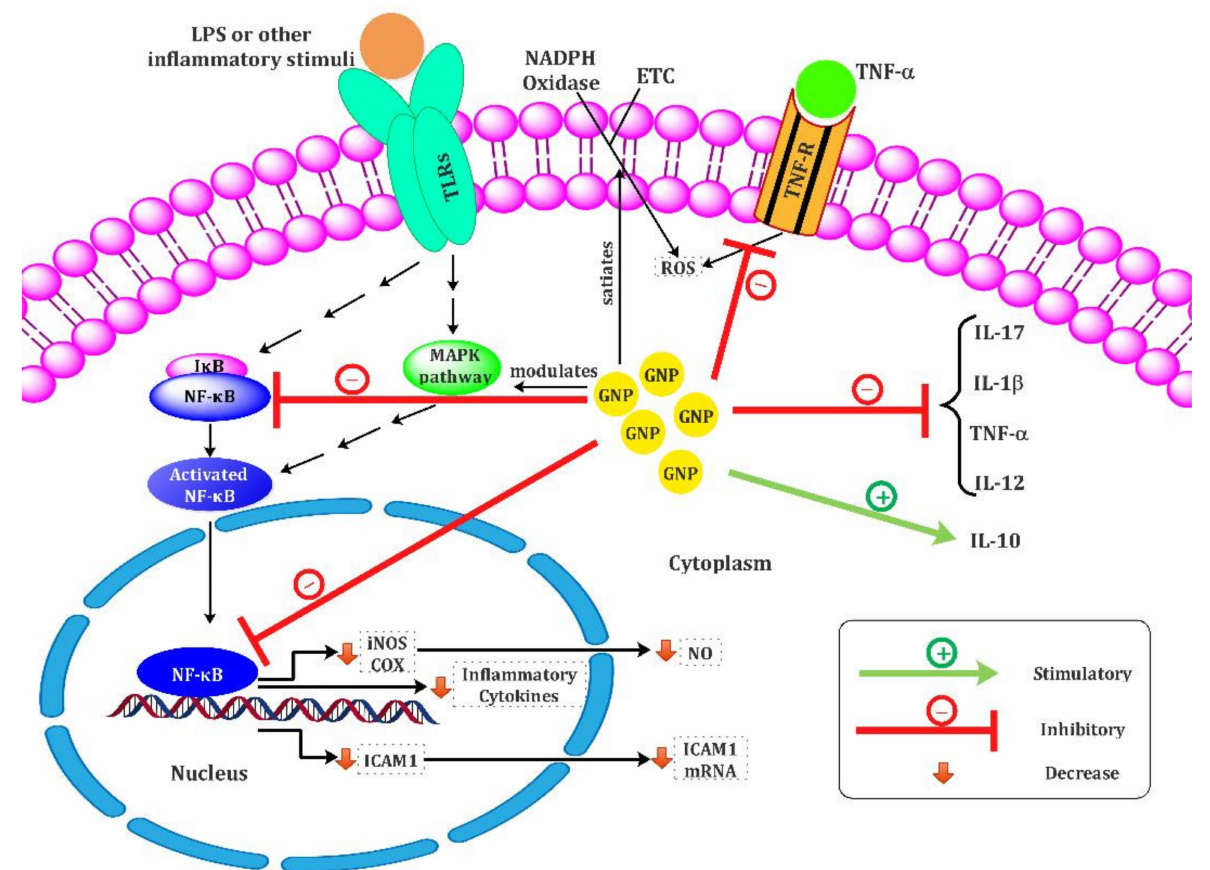
Figure 1. The adopted mechanisms for anti-inflammatory effects of GNPs include; (1) modulation of MAPK and PI3K pathways in Kupffer cells (liver macrophages) and hepatic cells, and the MAPK pathway, a key mechanism of inflammatory signal transduction from the cell surface to the nucleus, which leads to activate transcription factors and alterations in gene expression following LPS binding to TLRs. The PI3K pathway is involved in gene expression, protein synthesis, cell proliferation, and cytokine stimulation. GNPs negatively regulate Kupffer and hepatic satellite cells’ activity and affect their pro-inflammatory cytokine profile and oxidative stress via the modulation of AKT/PI3K and MAPK signaling pathways. In addition, the GNP treatments could reduce the activation of NF- κ B through ERK1/2MAPK/Akt/tuberin-mTOR pathway- mediated targeted inflammatory gene expression and cellular stress responses. (2) Significant inhibiting the production of several pro-inflammatory cytokines such as LPS-triggered TNF- α , IL-1 β , and IL-17, which can downregulate IL-1 β -induced epithelial cells proliferation. Moreover, GNPs could decrease the raised level of IL-12 production, which could leads to a change in the cell-mediated immune response of pro-inflammatory response (TH1) to anti-inflammatory response (TH2). (3) Reducing ROS production; the reactive oxygen species (ROS) are oxygen metabolites (OH − , O2 − , H 2 O 2 ) that have potent oxidizing features and can oxidize proteins and lipids in the cells and causes DNA damage. Reactive nitrogen species (RNS) are a combination of superoxide anion (O2 − ) and NO, which induce nitrosative stress and promotes the production of ROS. GNPs could lead to satiating and downregulating the phagocyte-produced ROS in a dose-dependent manner. Therefore, GNPs act as potential anti-oxidant and anti-inflammatory